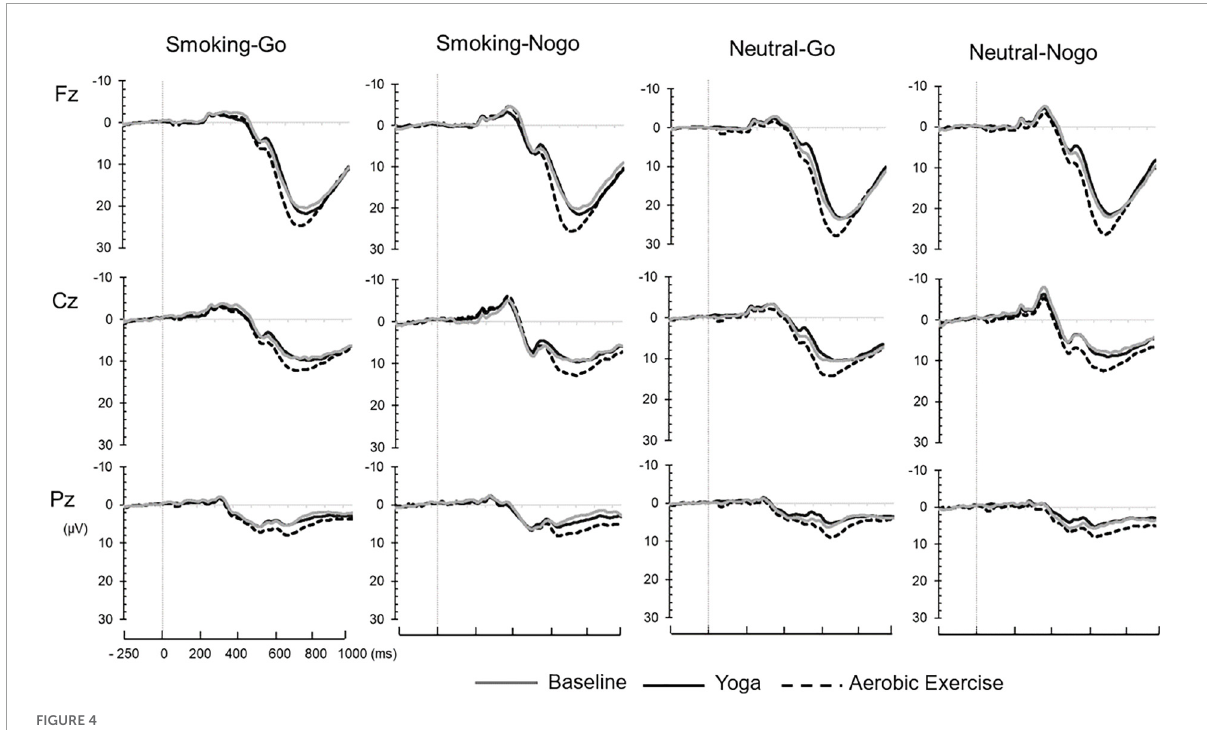
FIGURE4 Grand-averaged ERP